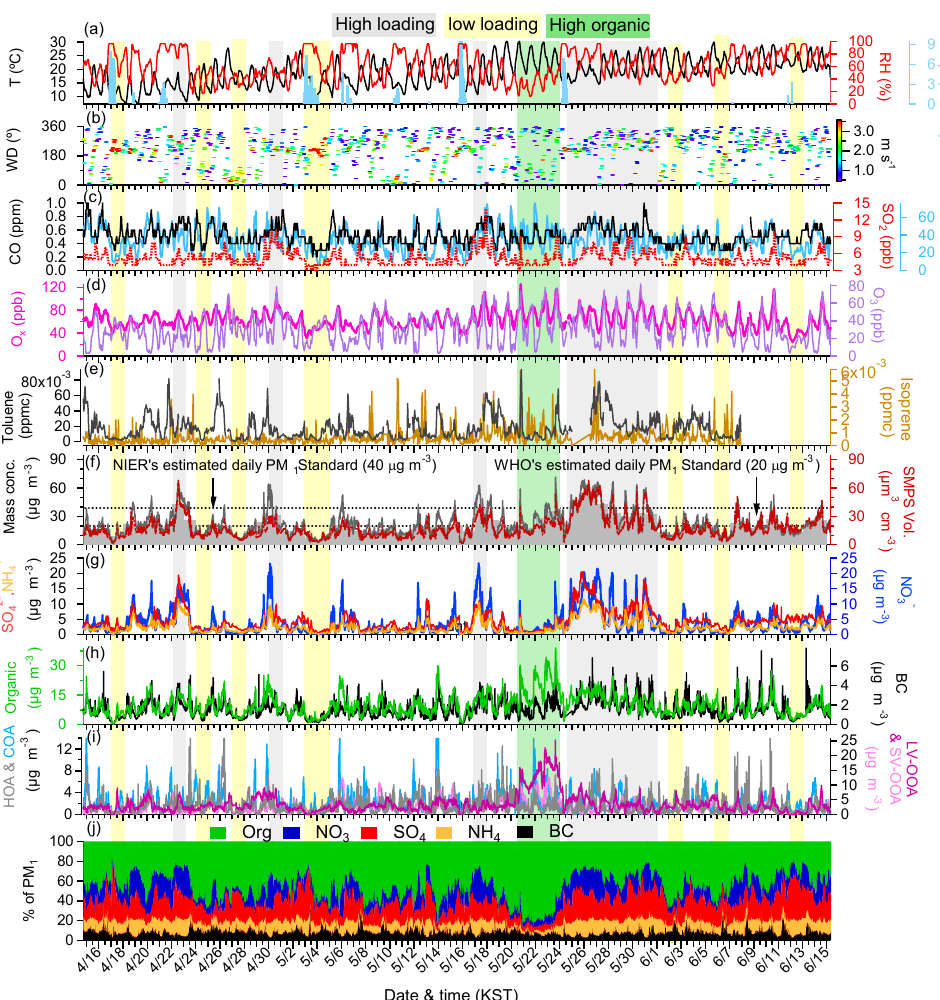
Figure 2. Overview of the temporal variations of submicron aerosols at the Korea Institute of Science and Technology (KIST) in SMA from 14 April to 15 June 2016: (a) time series of ambient air temperature ( T ), relative humidity (RH), and precipitation (Precip.); (b) time series of wind direction (WD; 0 ◦ indicates north, 90 ◦ indicates east), with colors showing different wind speeds (WS); (c) time series of CO,SO 2 , and NO 2 ; (d) time series of O x (NO 2 + O 3 ) and O 3 ; (e) time series of toluene and isoprene; (f) time series of total particulate matter (PM 1 ) and scanning mobility particle sizer (SMPS) volume concentrations; also shown are the 24h averaged PM 1 + BC with bars. Estimated NIER and WHO daily PM 1 standards (40 and 20µgm − 3 , respectively) are also shown with dashed lines for the comparisons; (g) time series of the nitrate (NO − ), sulfate (SO 2 − ) and ammonium (NH + ) aerosols; (h) time series of the organic (Org.) and BC aerosols; (i) time series of each 3 4 4 factor derived from the positive matrix factorization (PMF) analysis; (j) time series of the mass fractional contribution of organic aerosols (Org.), nitrate (NO − ), sulfate (SO 2 − ), ammonium (NH + ), and BC to total PM 1 . 3 4 4 coupled with the time series of concentration of each